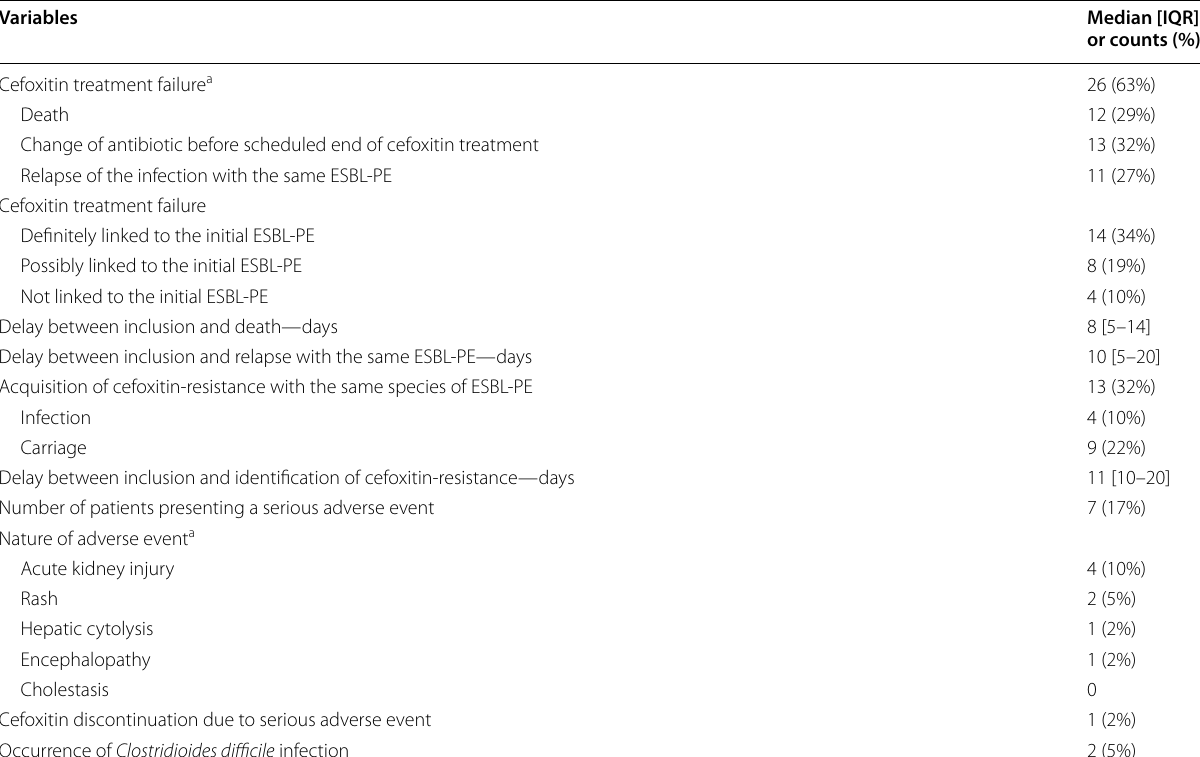
file 4: Figure S2. Table 2 shows cefoxitin TDM and PK modeled values. The cefoxitin PK/PD target serum con- centration of efficacy ( f T >MIC 100%) was achieved in = 34 patients (83%), based on model predictions (PK pro- file based on the Bayesian posterior estimates). How- ever, only 19 (46%) patients achieved the PK/PD target f T >MIC ECOFF 100% (C ss 5 MIC ECOFF in the case of = ≥ × continuous IV administration). tional file 5: Figure S3 and Additional file 6: Figure S4. Dosage requirements strongly depended on renal func- tion. The standard dosage of 6 g/24 h administered by continuous IV was not sufficient to achieve the PK/PD severe renal impairment or receiving continuous RRT. In patients with normal renal function, e.g., with CCR IBW